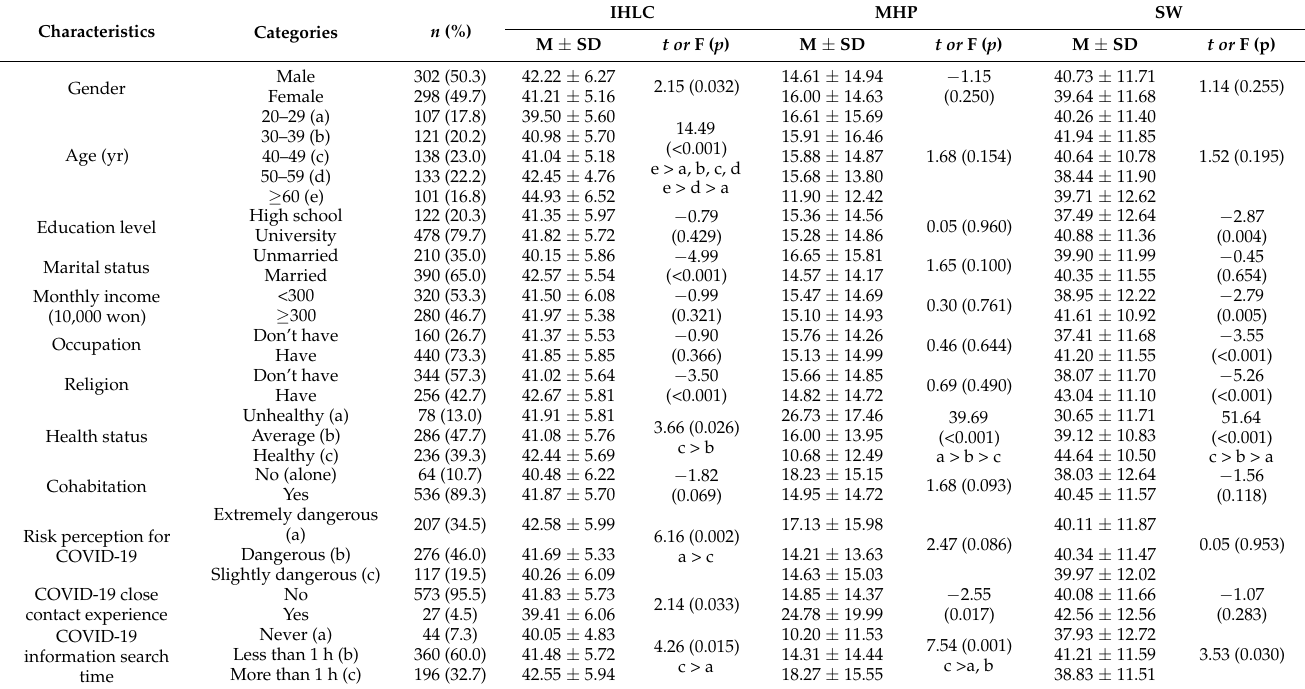
Table 1. Difference in Measured Variables according to General Characteristics ( n = 600).